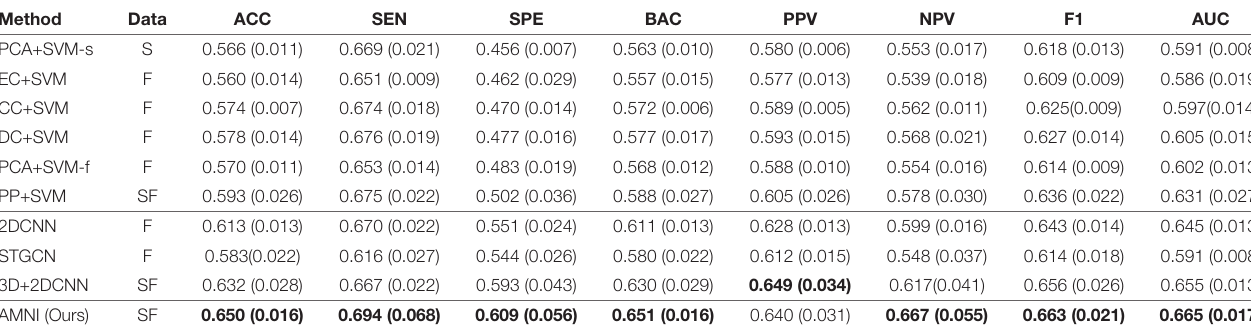
TABLE 3 | Classification results in terms of “mean (standard deviation)” achieved by ten methods in MDD vs. HC classification, with best results shown in